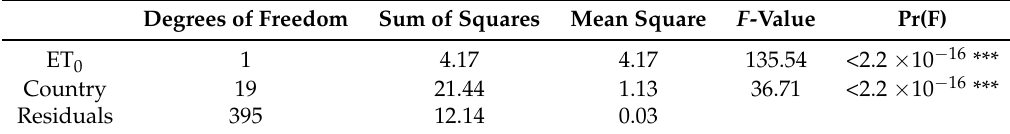
Table A4. *** represent estimates that have p -values smaller than 0.001.